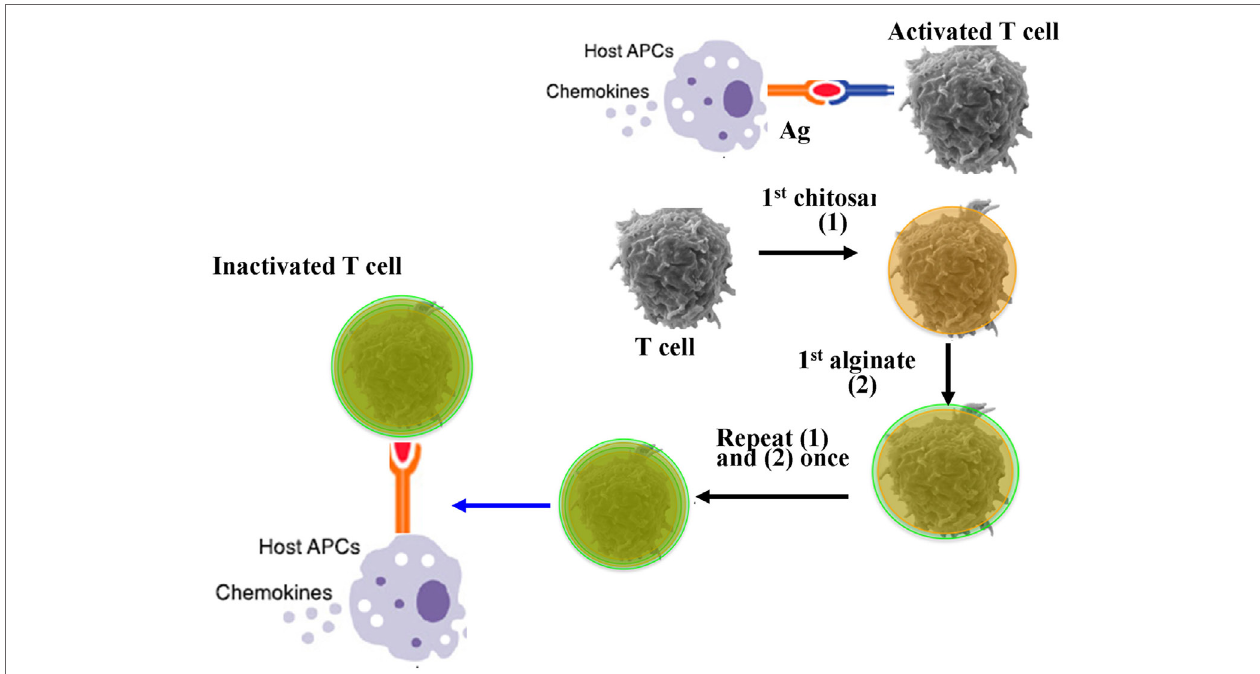
FiGURe 2 | Nanoencapsulation of allogeneic T cells mitigate graft-versus-host disease (GVHD). Host antigen-presenting cells (APCs) activate donor T cells through presenting antigens. Donor T cells are coated with a nanoscale biocompatible and biodegradable film of chitosan and alginate. Encapsulated T cells could not receive the activated signals from host APCs, which could attenuate GVHD without compromising graft-versus-leukemia